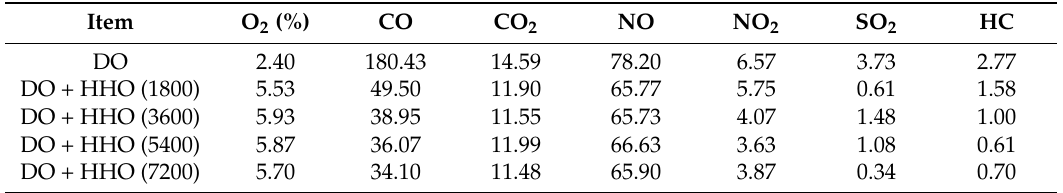
Table 13. The amounts of various particles when combining DO with various amounts of HHO.